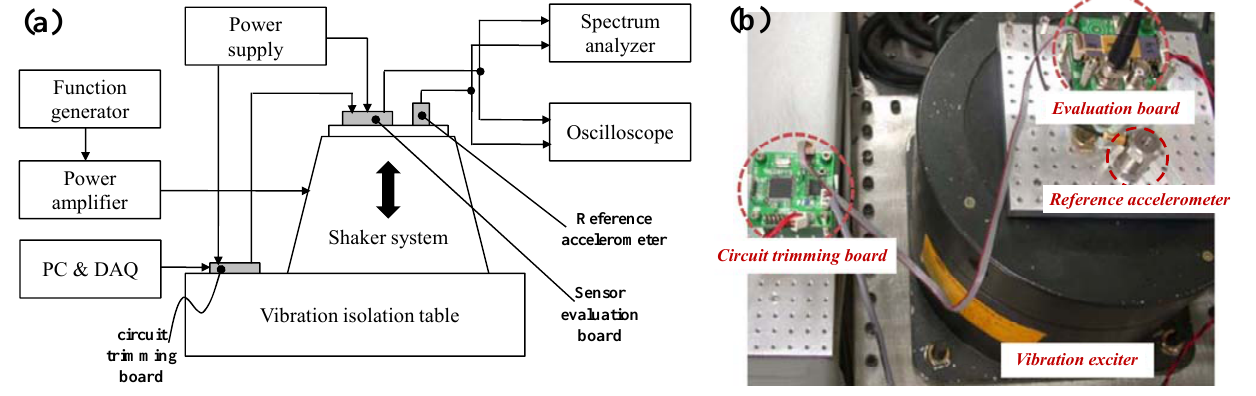
Figure 15. (a) Block diagram of experimental setup. (b) Photograph of experimental setup. Experimental